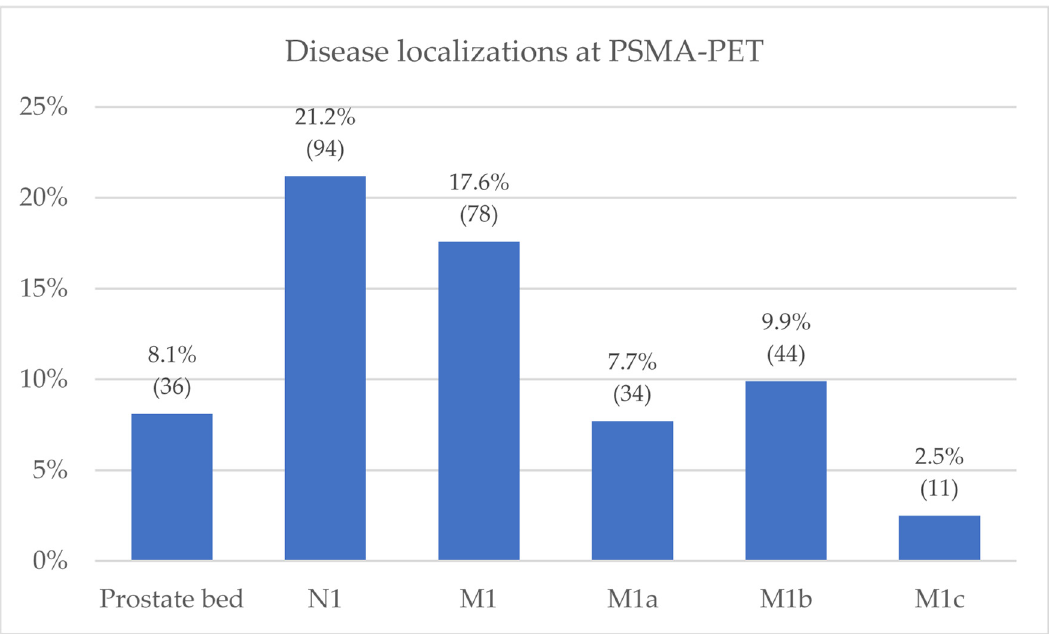
Figure 1. PSMA-PET results according to miTNM classification ( N = 443).